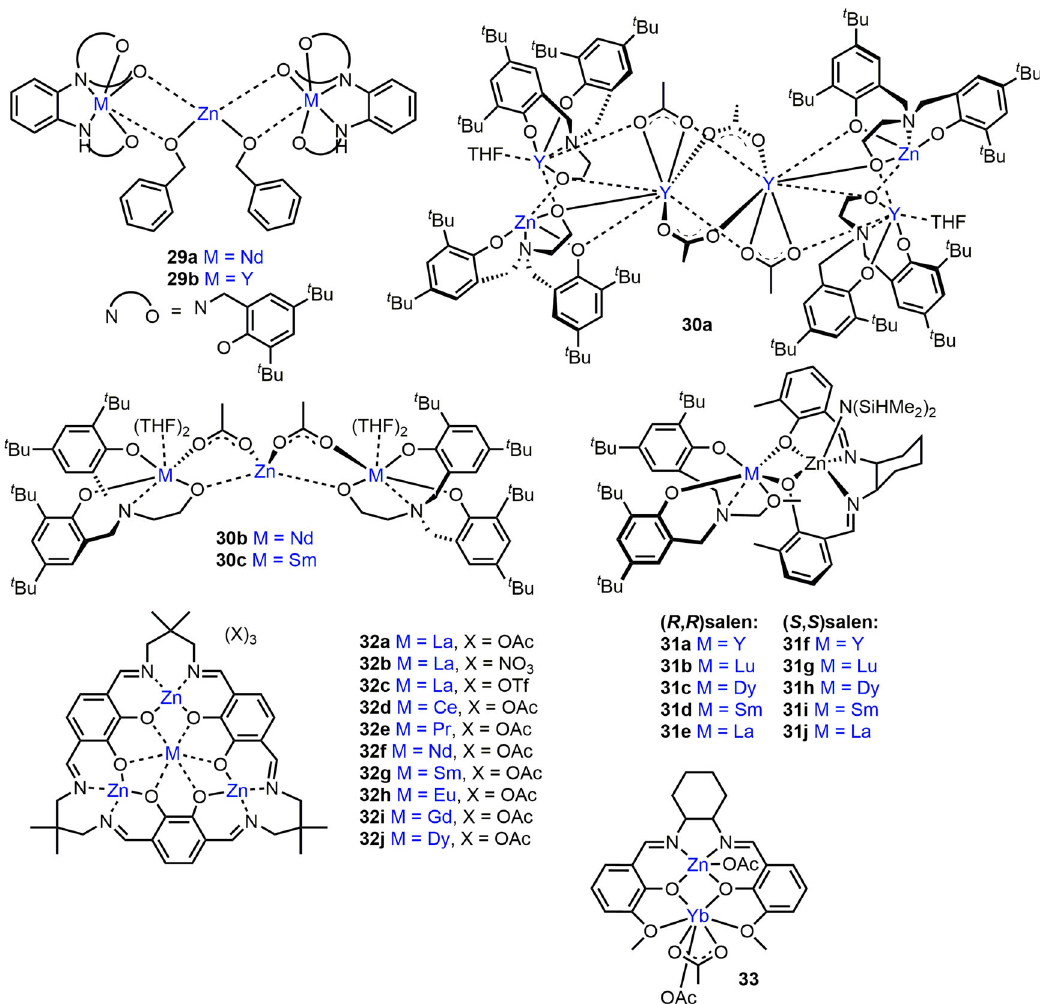
Fig. 7 Heterometallic Ln/Zn complexes for epoxide ROCOP with CO 2 or cyclic anhydrides. Structural representation of zinc-based ROCOP catalysts featuring lanthanide heterometals from across the